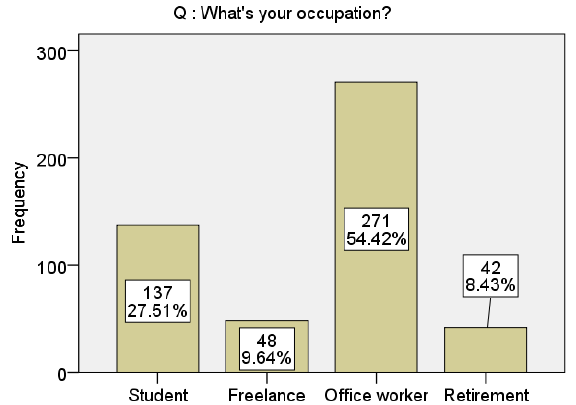
Figure 8. Age frequency.